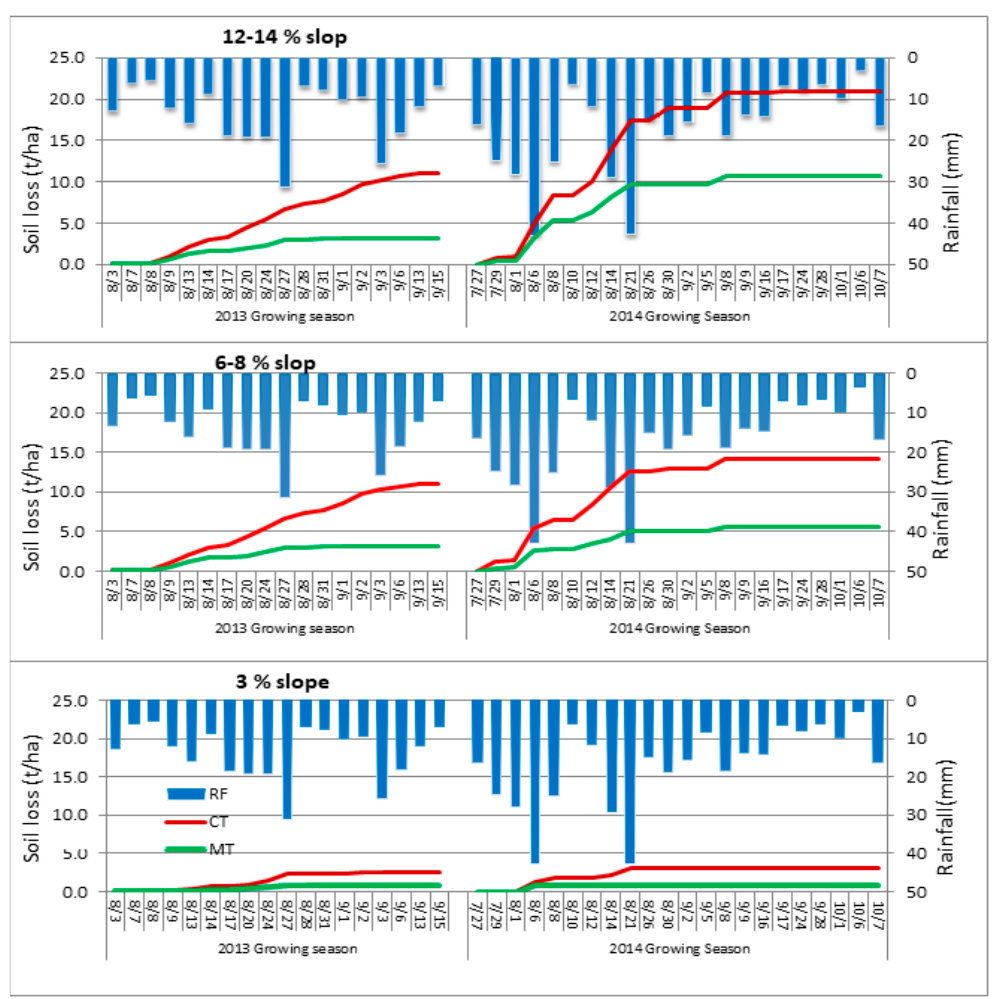
Figure 6. Cumulative soil loss in response to conventional and reduced contour tillage methods on maize planted in 3%, 6–8%, and 12–14% slope plots at Bolo Silase,